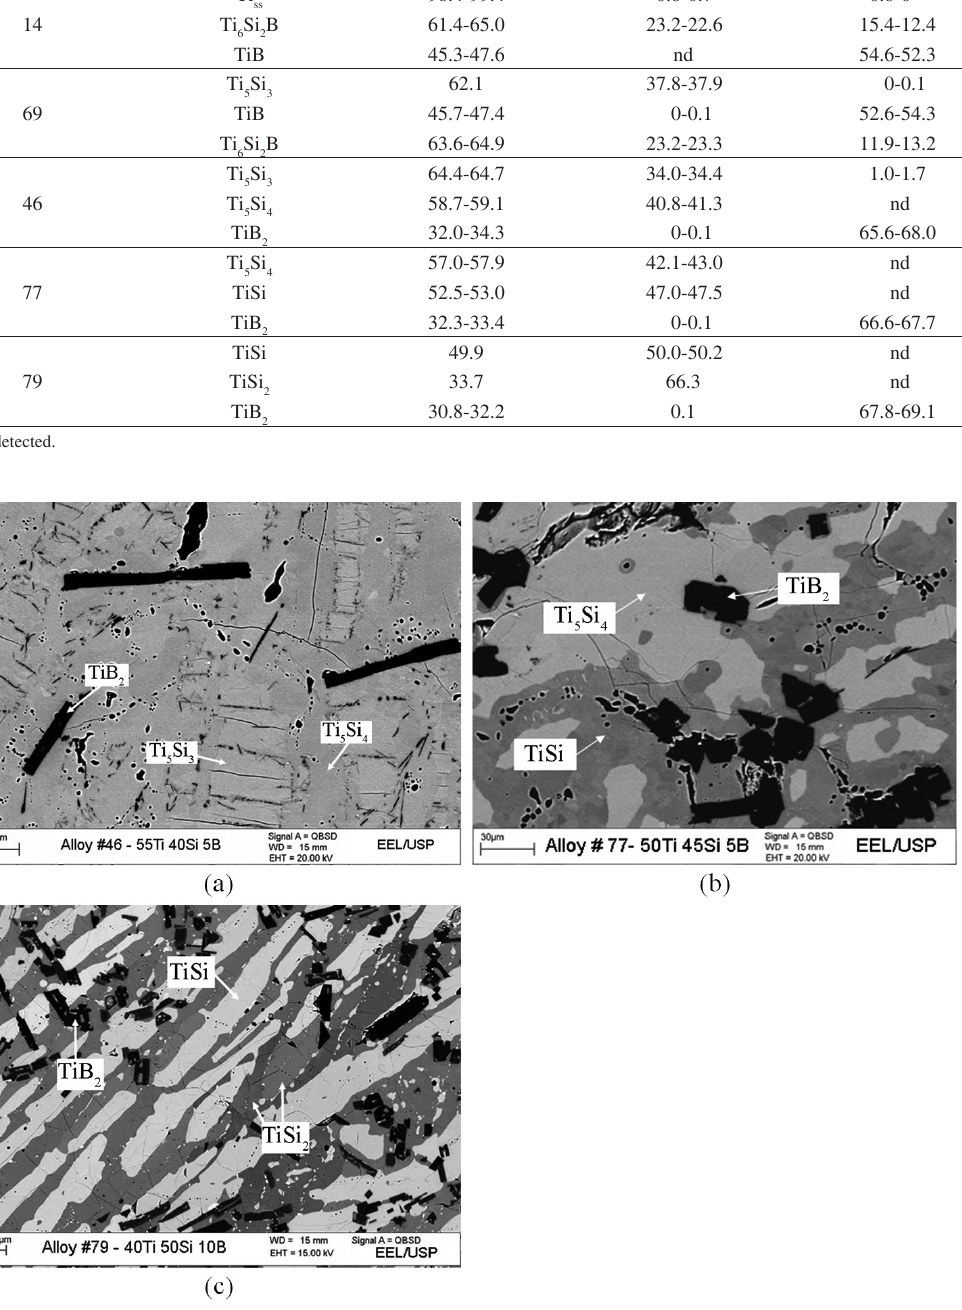
Figure 4. SEM/BSE micrographs from heat-treated Ti-Si-B alloys: (a) #46 (55Ti-40Si-5B); (b) #77 (50Ti-45Si-5B); (c) #79